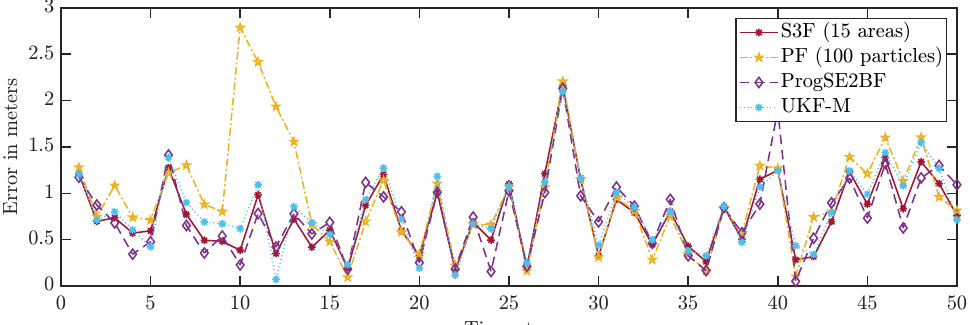
Figure 6. Position errors in all time steps in an example run.